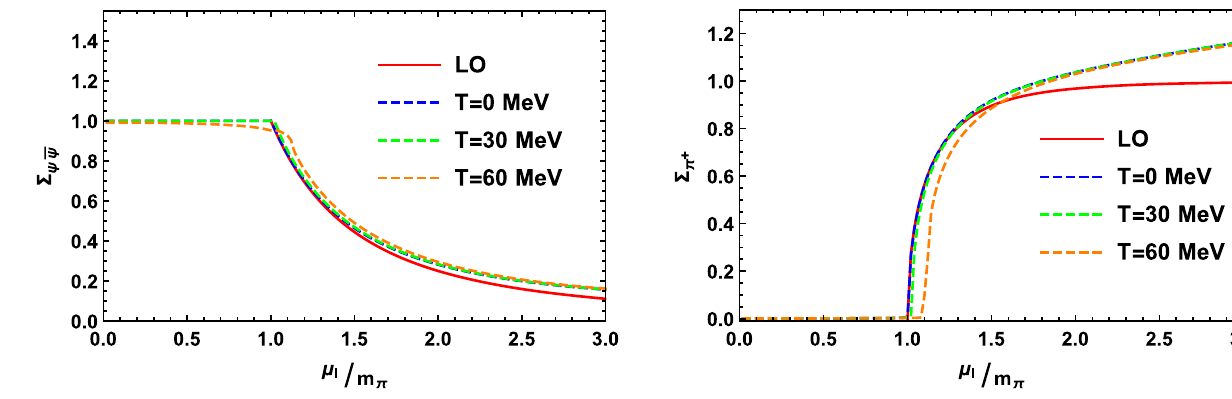
Fig. 4 Normalized quark condensate deviation, Σ ¯ ψψ , as a function of the normalized isospin chemical potential at vanishing and finite temperature to one loop. See main text for details